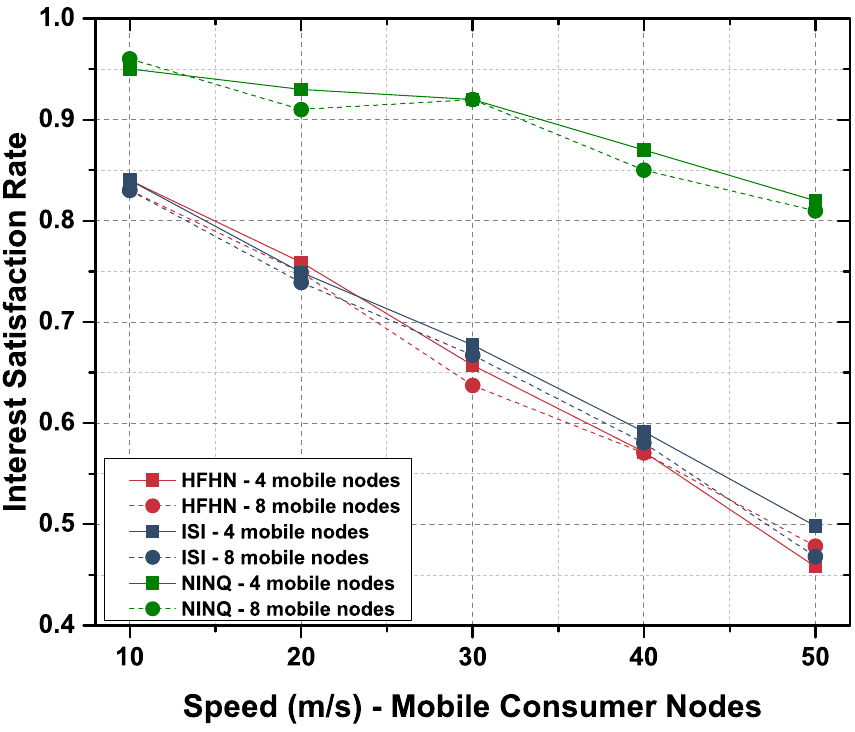
Figure 11. ISR in a network by speed of mobile